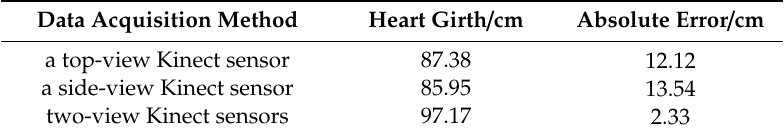
Table 1. Pig heart girth measurement results obtain by di ff erent data acquisition ways.